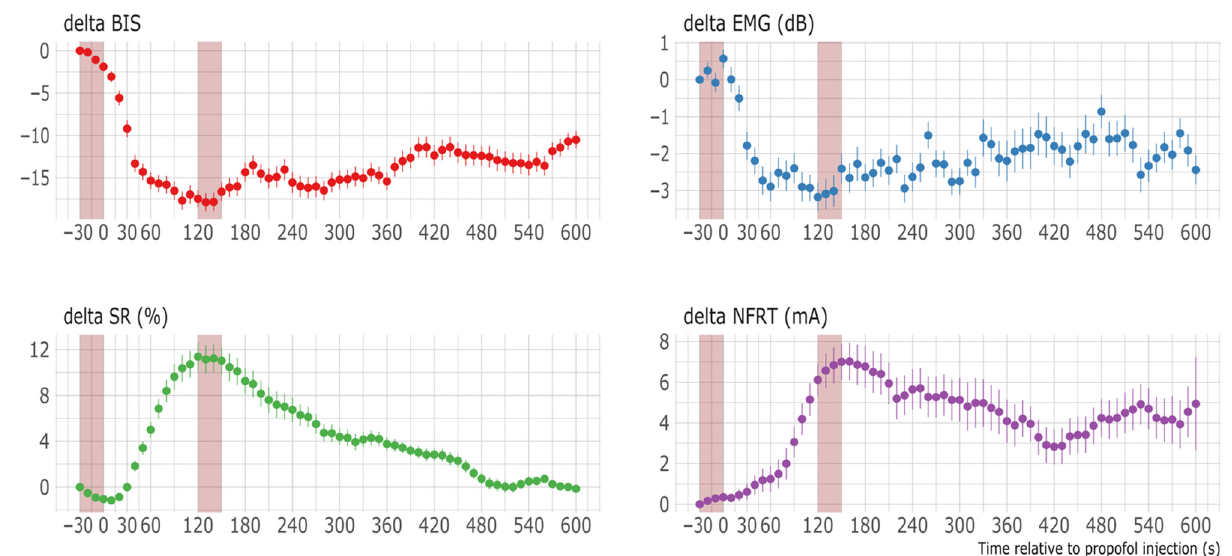
Figure 2. Changes from baseline values (delta) of Bispectral Index (BIS), electromyogram (EMG), suppression ratio (SR), and nociceptive flexion reflex threshold (NFRT) over time with respective 95% CIs. Propofol was administered at 0 s. The red areas mark the periods t0 and t1, in which the values for BIS, EMG, SR, and NFRT were averaged.